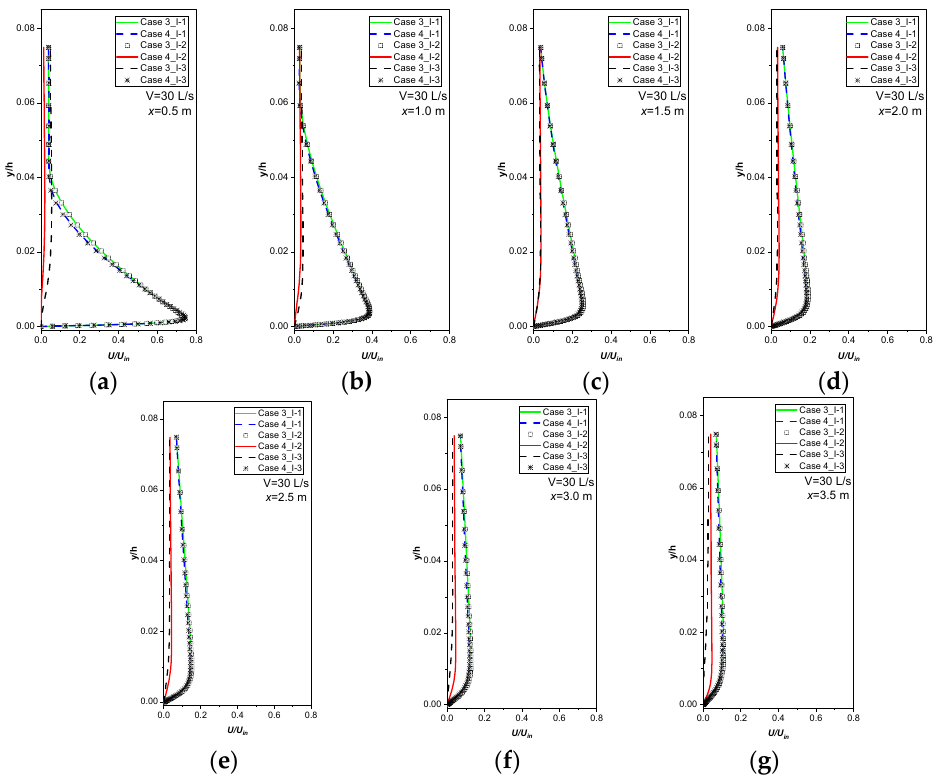
Figure 5. ( a – g ) Show the velocity developments along the centerline of the floor for all evaluated cases with V = 30 L/s at x distances 0.5–3.5 m.